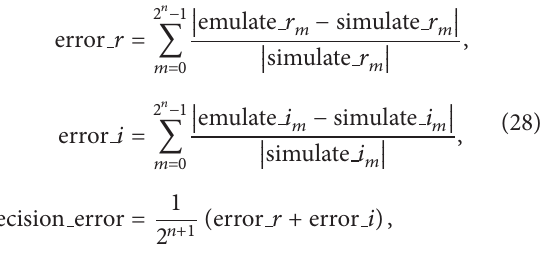
1, only one bit is required to represent the integer